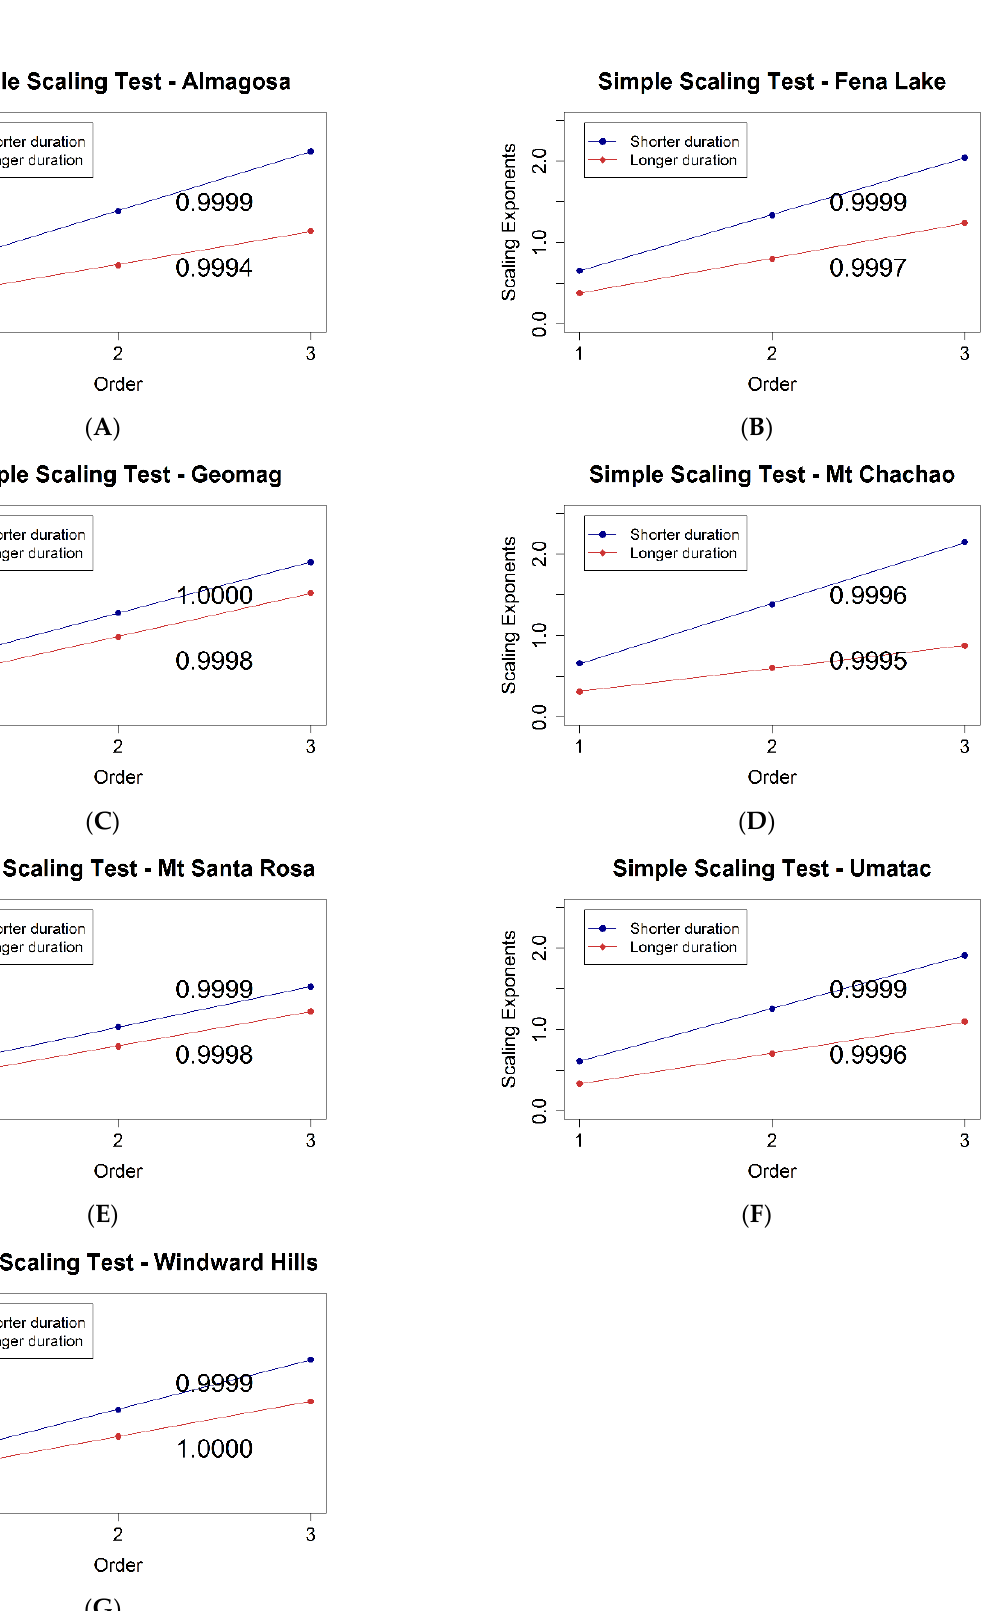
Figure 4. Scaling properties of AMPs. ( A ) is the NCM plot for Almagosa, ( B ) for Fena Lake, ( C ) for Geomag, ( D ) Mt. Chachao, ( E ) for Mt. Santa Rosa, ( F ) for Umatac, and ( G ) for Windward Hills, respectively.